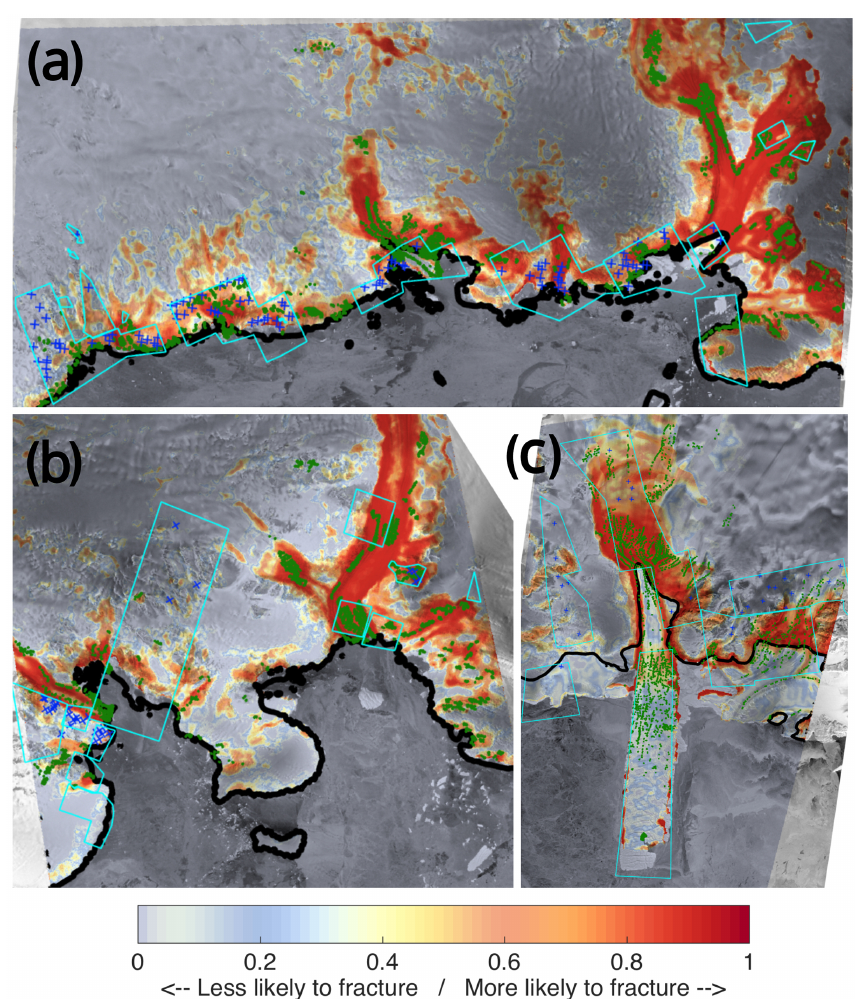
Figure 5. Modelled probability of a fracture for group 2, Rayner Thyner IS (a) and Edward VII IS (b) , and group 1: Drygalski IS (c) . Observed surface fractures are shown in green, and observed non-fractured ice is marked with blue crosses. Cyan boxes represent regions where high-resolution images were available. Black solid line shows the location of the grounding